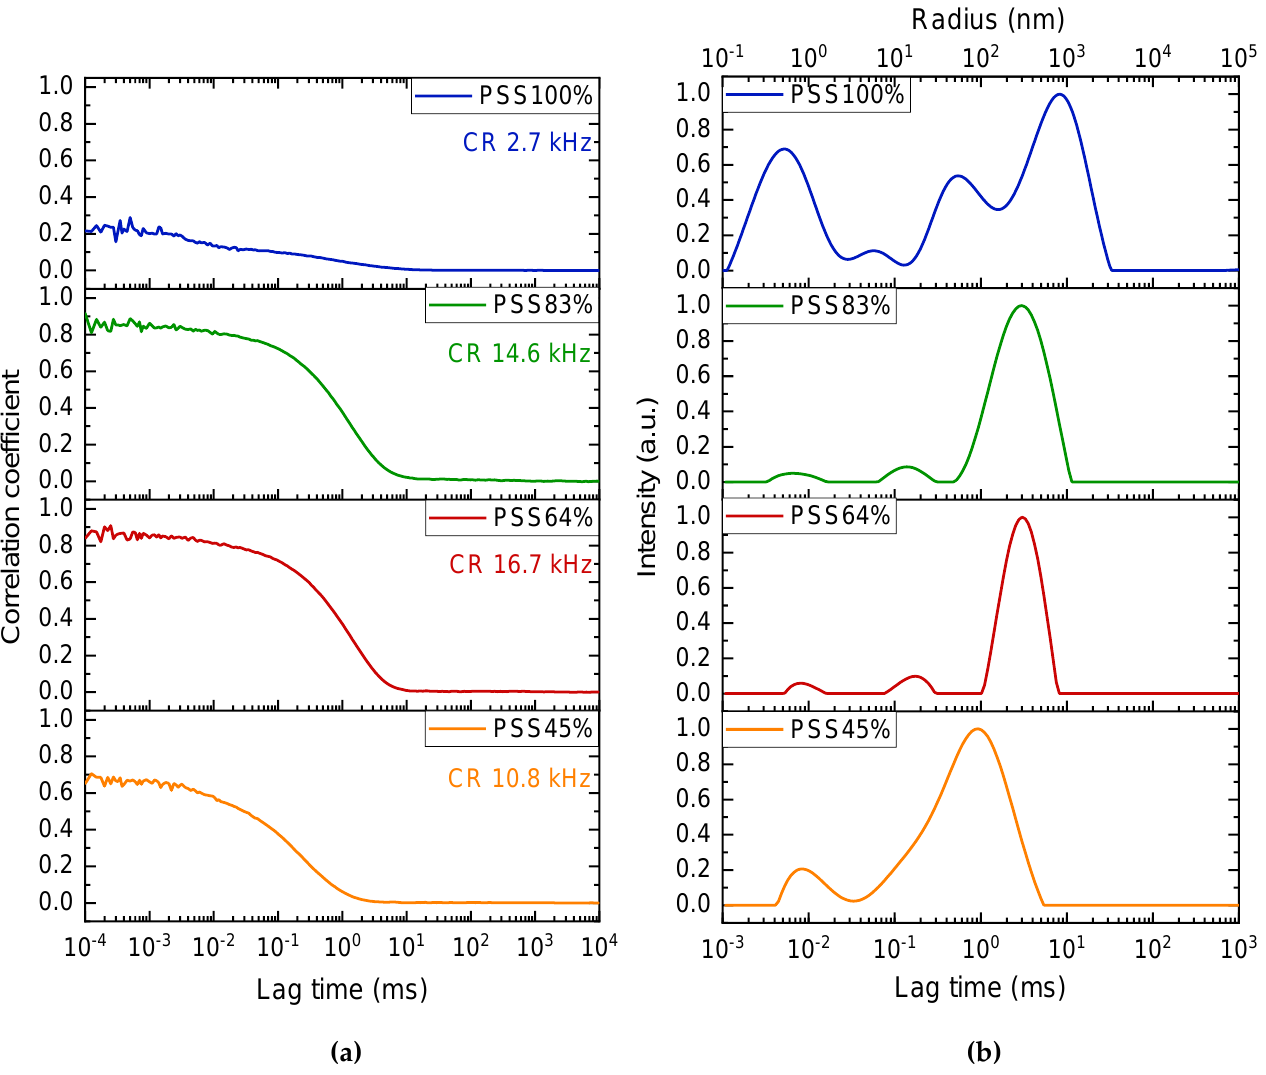
Figure 3. DLS analysis of aqueous solutions of P(St-co-SSNa) varying in the degree of sulfonation. ( a ) Normalized intensity autocorrelation functions. The scattering intensity of P(St-co-SSNa) solutions is given as the count rate (CR) determined at 90 ◦ detection angle and normalized by the polymer mass concentration (g/L). ( b ) Intensity-average relaxation time distributions. The corresponding unweighted radii are shown on the top axis. All PE solutions were prepared at a concentration of 6 mM in charged units.